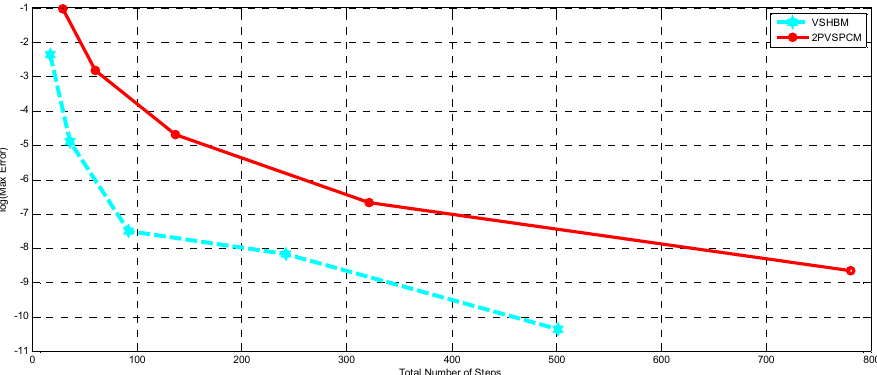
Figure 5. Efficiency curves for Kepler problem in terms of number of steps versus maximum error.